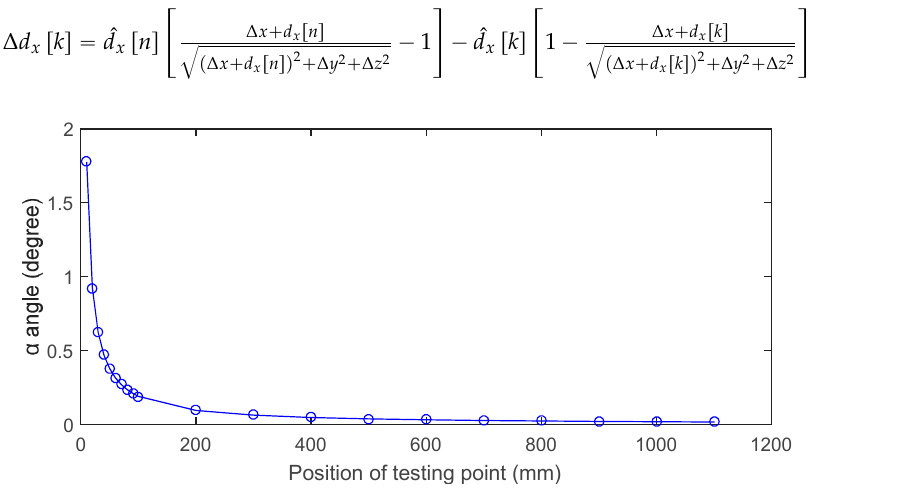
Figure 11. The deviation of the α angle following measurement distance changes when Δ x , Δ y and Δ z are 0.7978, 0.2715 and 0.1965 mm, respectively.